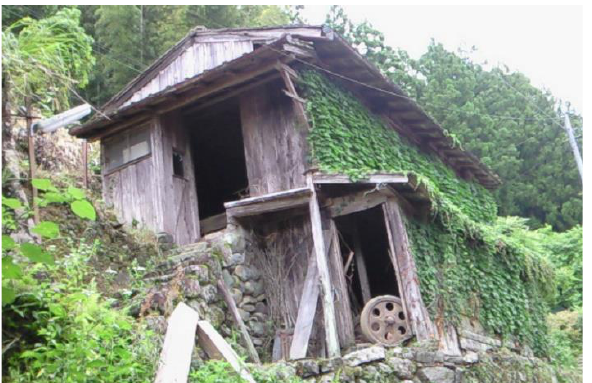
Figure 2. One of the oldest Agariya, in the Ukegawa area in Hongu-cho, destroyed after the flood of 2011.